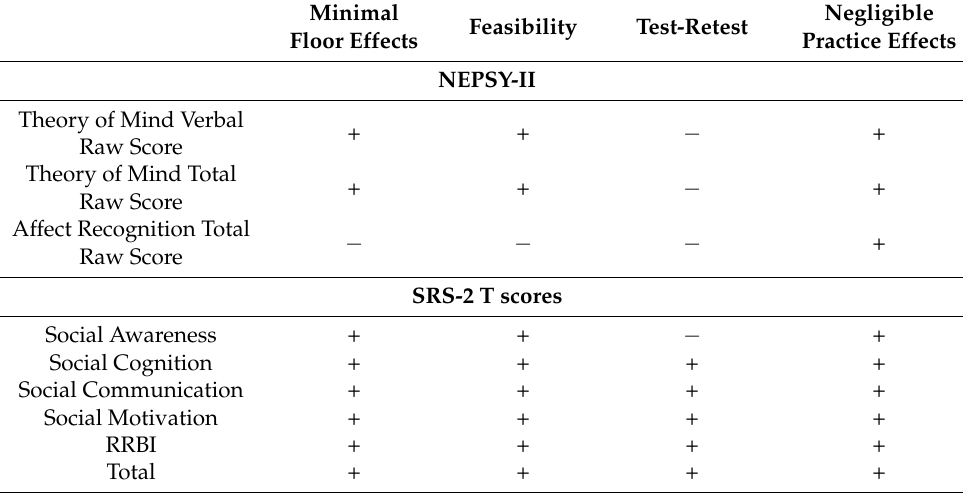
Table 5. Summary of social cognition and behavior measures assessed on a priori